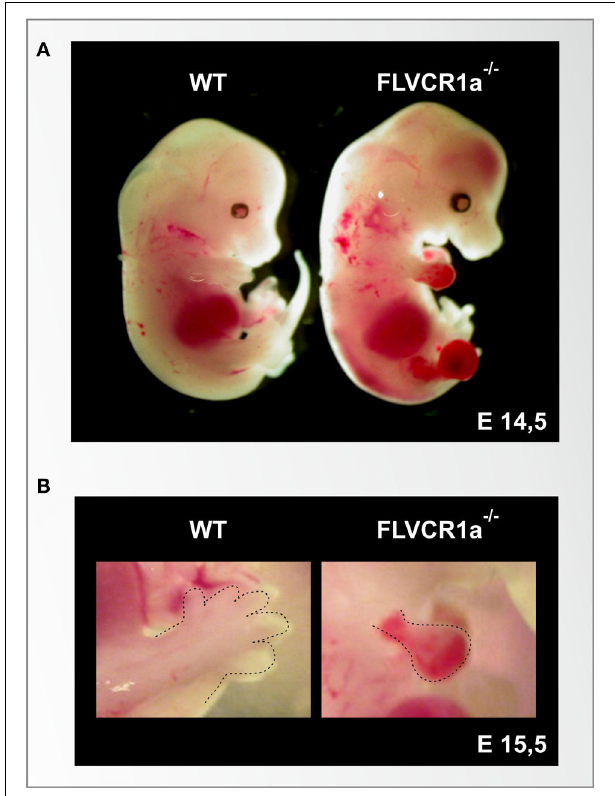
FIGURE 3 | The loss of the heme exporter FLVCR1a in mice causes embryonic lethality, skeletal malformation and extended hemorrhages. (A) Stereoscopic view of a wild-type (left) and a Flvcr1a − / − (right) embryo at the embryonic stage of E14,5. At this stage, the wild-type embryo shows normal skeletal structure, with fully formed limbs. The Flvcr1a − / − embryo shows extended hemorrhages and edema through the body, in particular in the limbs, back and head. Flvcr1a − / − embryos show skeletal malformations, as suggested by the absence of the lower jaw and properly formed digits. (B) An enlarged view of E15,5 wild-type and Flvcr1a − / − anterior limbs (marked with a broken line). In the Flvcr1a − / − embryo, the limbs show severe hemorrhage, leading to impairment in limb and toe